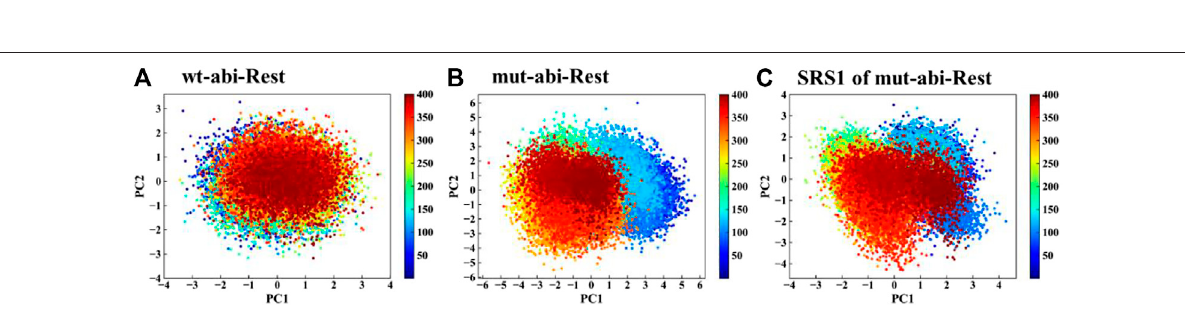
Frontiers in Chemistry |